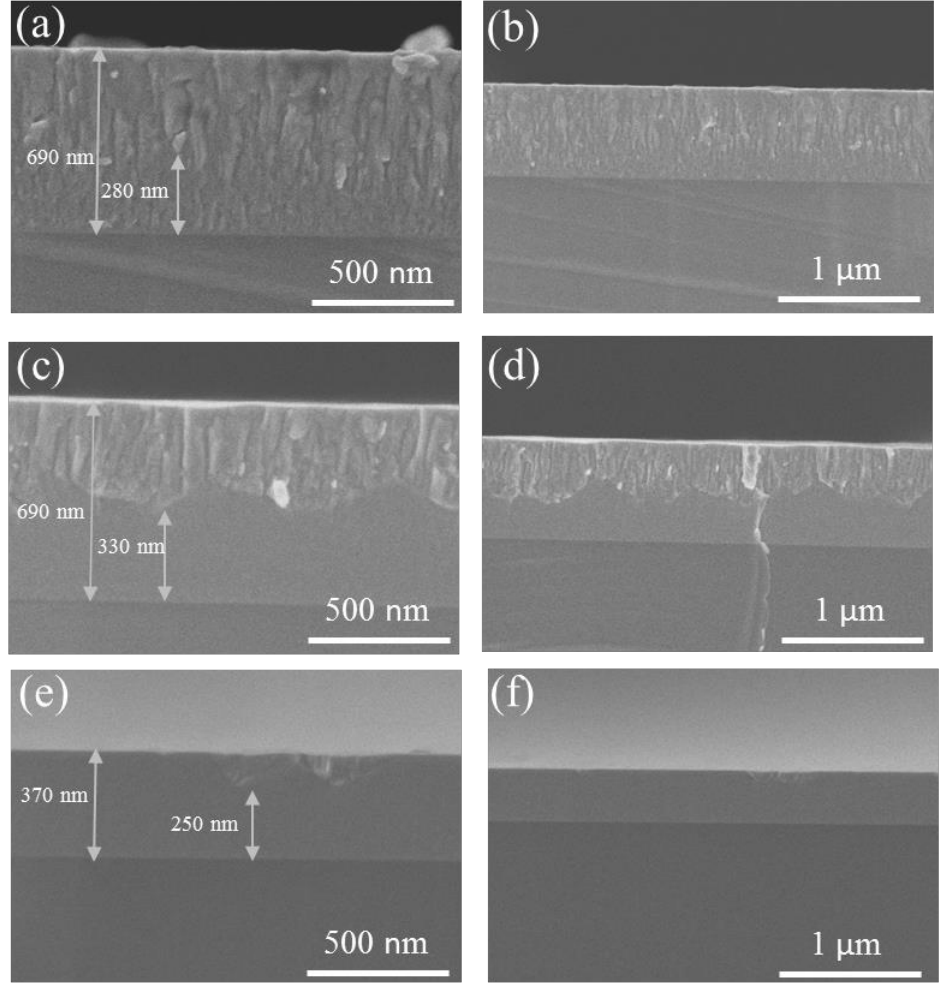
Figure 4. Representative SEM cross-section images for samples for G1 ( a ) and ( b ), sample deposited at Pw 0.1 Pa, p O2 = 0.06 Pa; G2 ( c ) and ( d ), sample deposited at Pw 0.25 Pa, p O2 = 0.20 Pa; and G3 ( e ) and ( f ), at Pw 0.5 Pa, p O2 = 0.31 Pa.